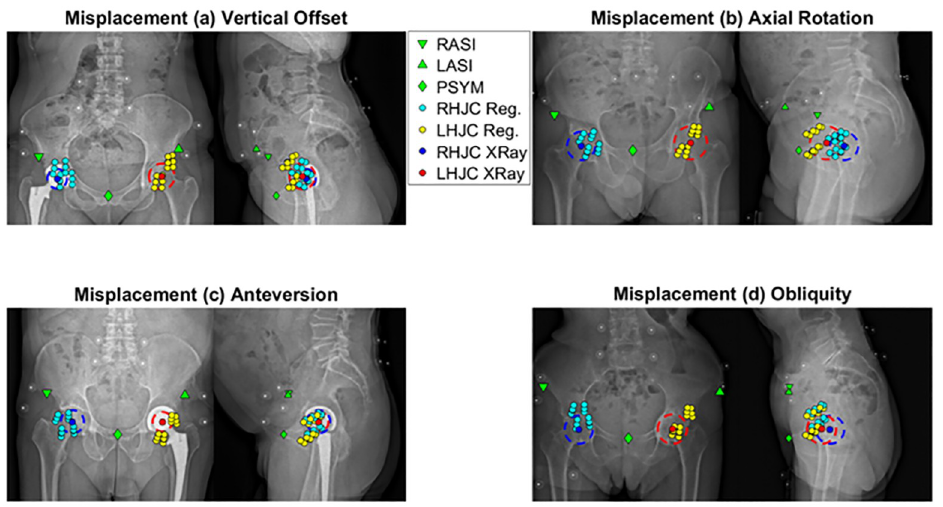
Fig 3. Hip joint centre: Regression versus bi-plane X-ray.